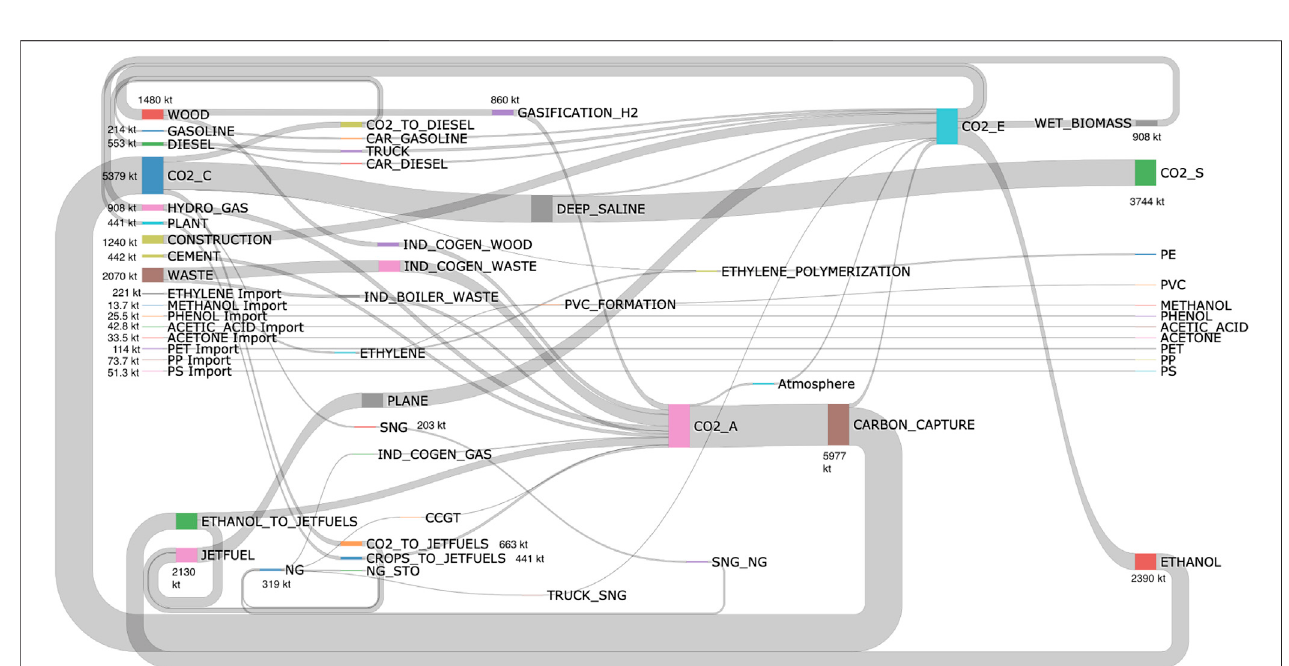
FIGURE 9 | Annual carbon fl ow (kt-C) in a fossil-fuel-free and net-zero-emission system.